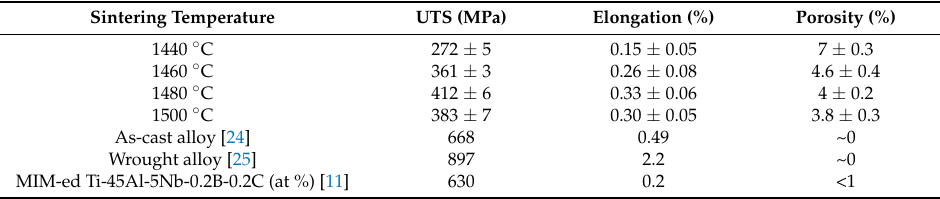
Table 5. Tensile properties and porosities of the alloys investigated at room